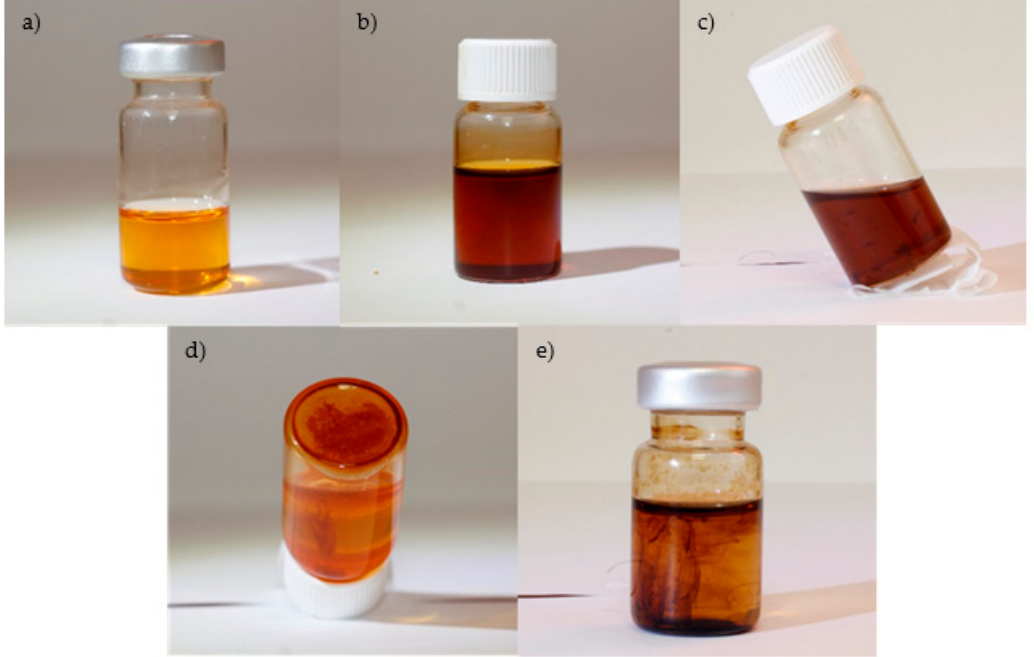
Figure 7. Appearance of the solutions after the tests (From top left to bottom right): ( a ) Type 1, NE + FF1 (0.1 g/L), ( b ) Type 1, MO + FF2 (0.1 g/L) ( c ) Type 2, precipitate suspended, ( d ) Type 3, precipitate at the bottom of the vial, ( e ) Type 4, NP could not be dispersed.